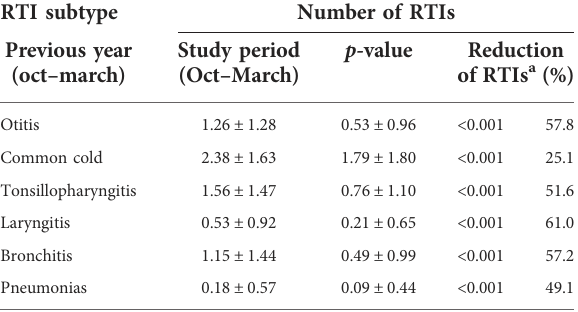
TABLE 2 Incidence of RTI subtypes in all subjects ( n =994) in the